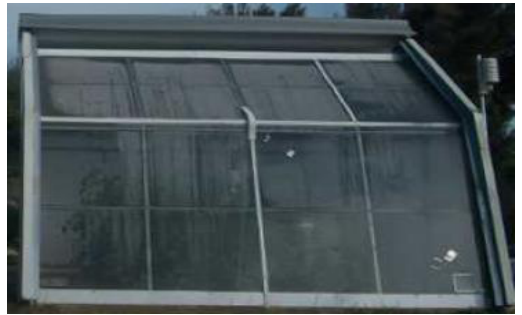
Figure 2. Experimental greenhouse.